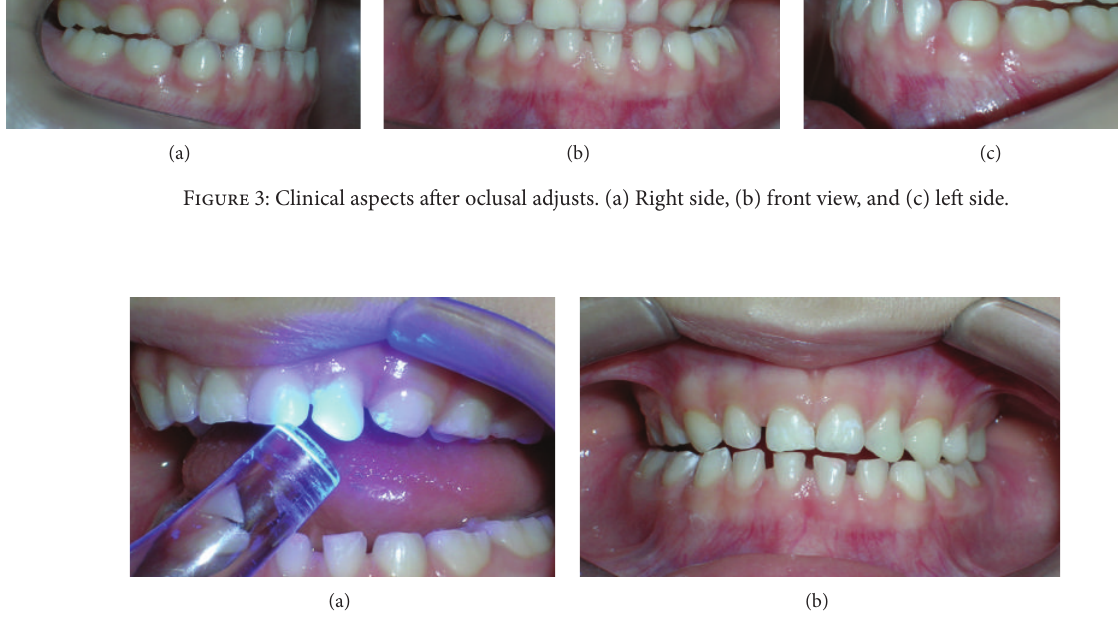
Figure 4: Confection of Planas Direct Tracks. (a) Photopolymerization of resin. (b) Front view after confection of Planas Direct Tracks centralizing the median